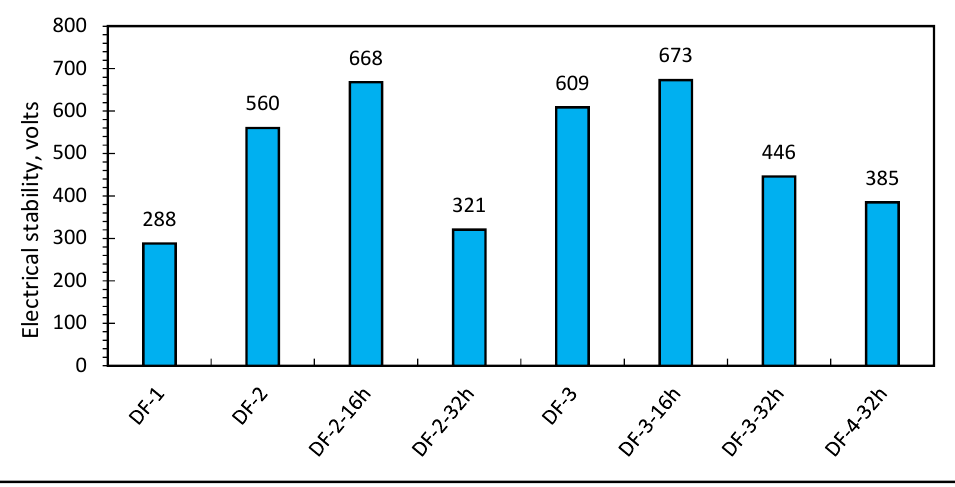
Figure 6. Electrical stabilities of oil-based drilling fluids .